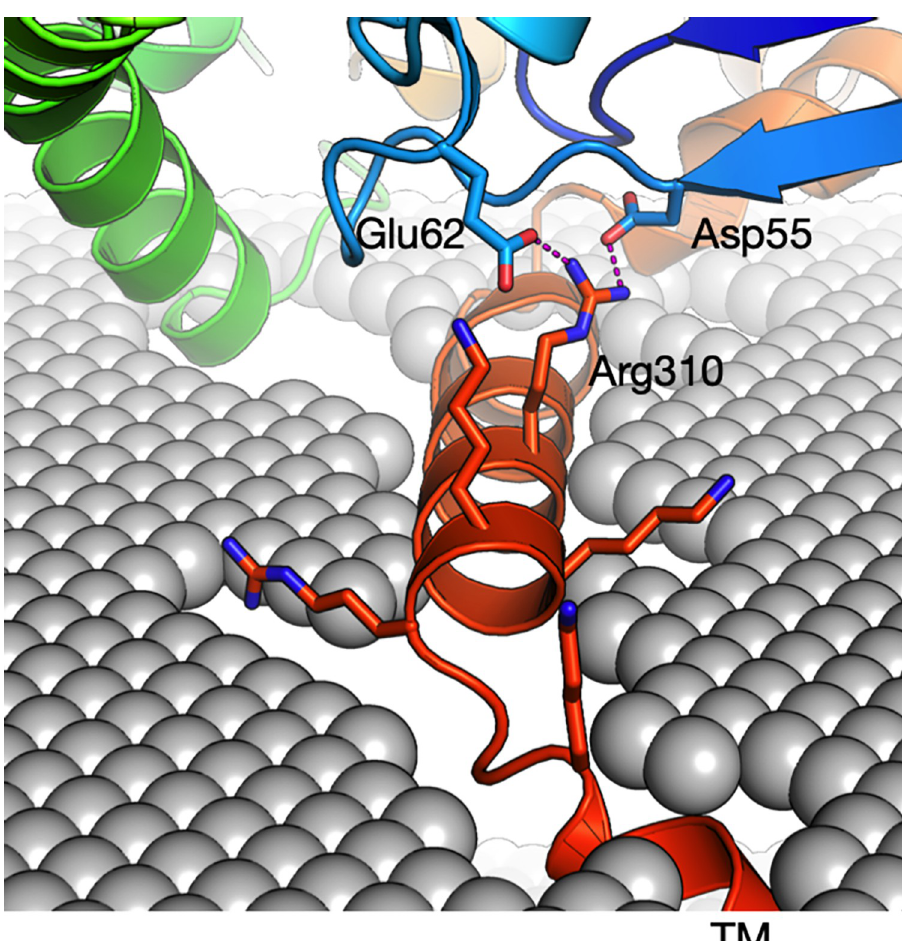
Fig 8. Location of Arg310 outside the GST-like core. Arg310 within the amphipathic helix preceding the transmembrane domain is predicted to make salt bridges back towards the core domain.